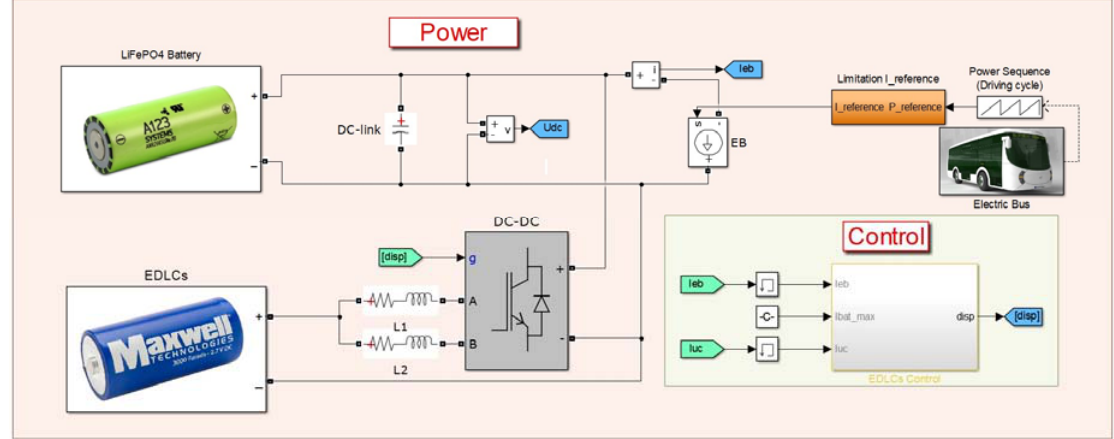
Figure 3. Matlab Simulink SimPowerSystem simulation model developed for the performed study.